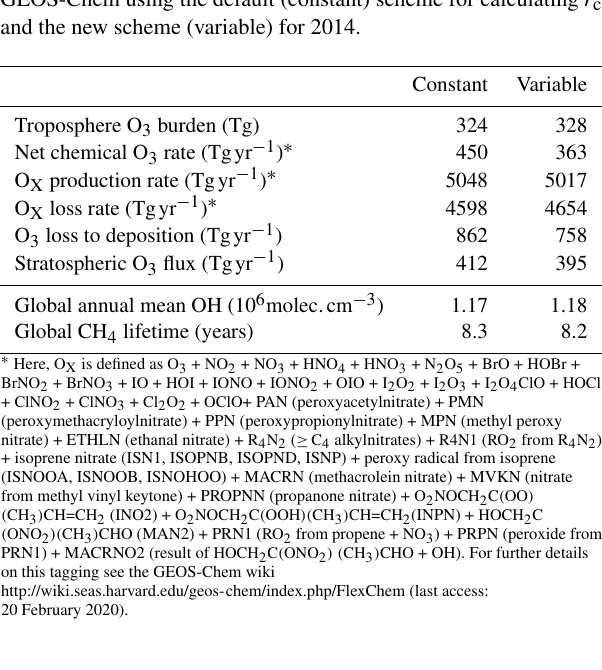
Table 3. Root mean square error (RMSE) of the model with the de- fault (constant) scheme for r c and the new scheme (variable) when compared to the observations at GAW sites calculated from monthly mean values of observations and model